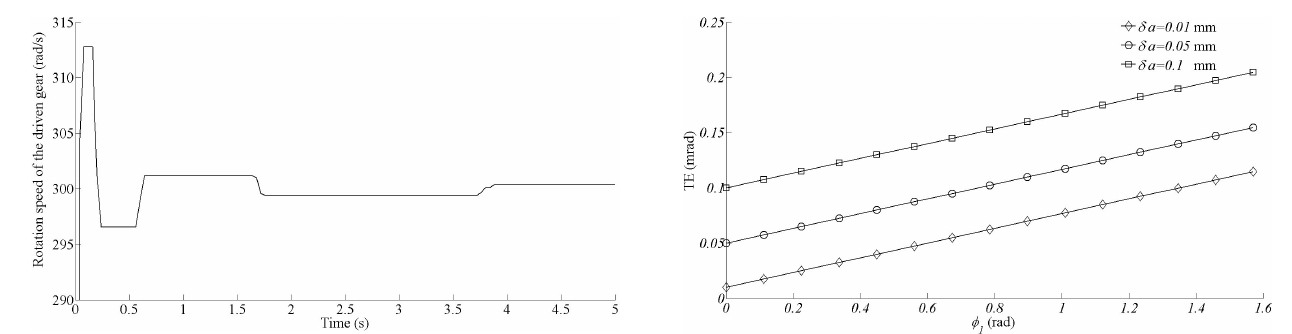
Figure 5. TEs of the unimproved NHGM with different center dis- tance errors.